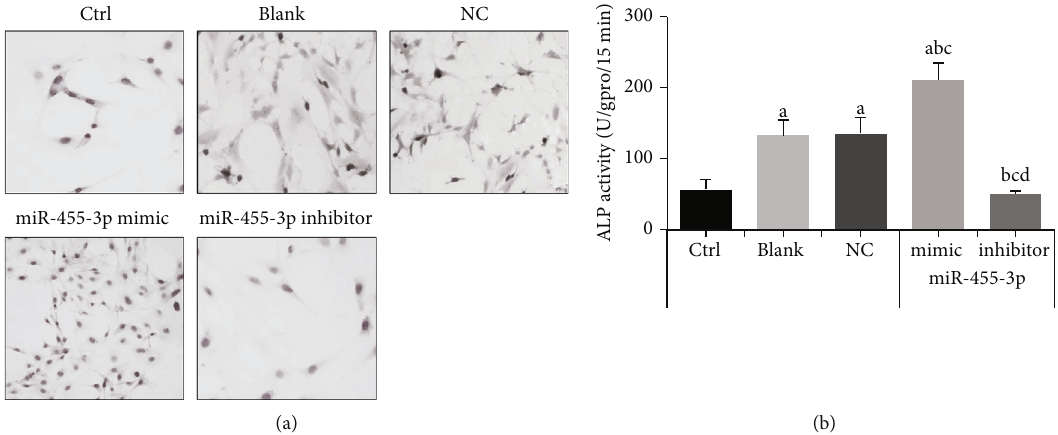
Figure 5: ALP staining and activity detection in BMSCs. (a) Observation on ALP staining in BMSCs ( × 100). (b) Detection results of ALP activity in BMSCs. Note: A, B, C, and D meant P < 0 : 05 in comparison to the Ctrl, blank, NC, and mimic groups, respectively.